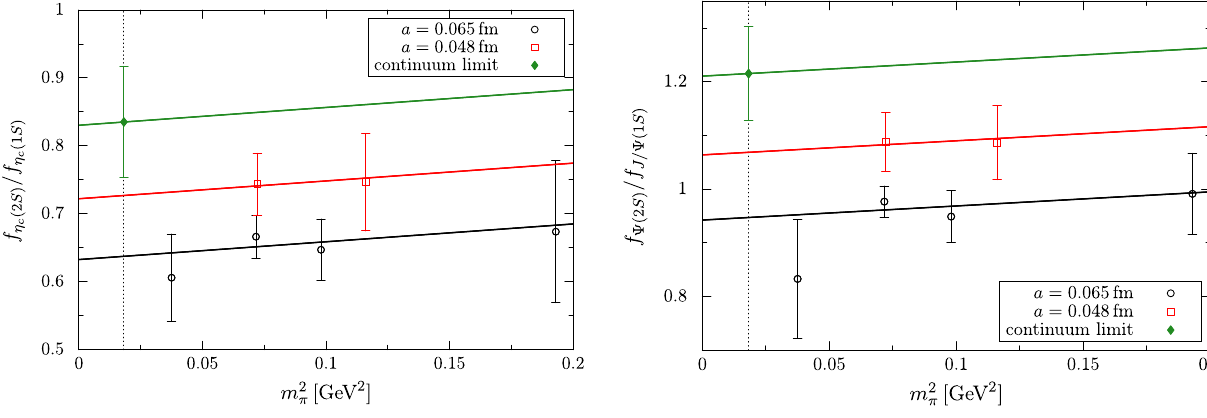
Fig. 9 Extrapolation at the physical point of f η include the systematic error obtained by changing the time range to fit f η